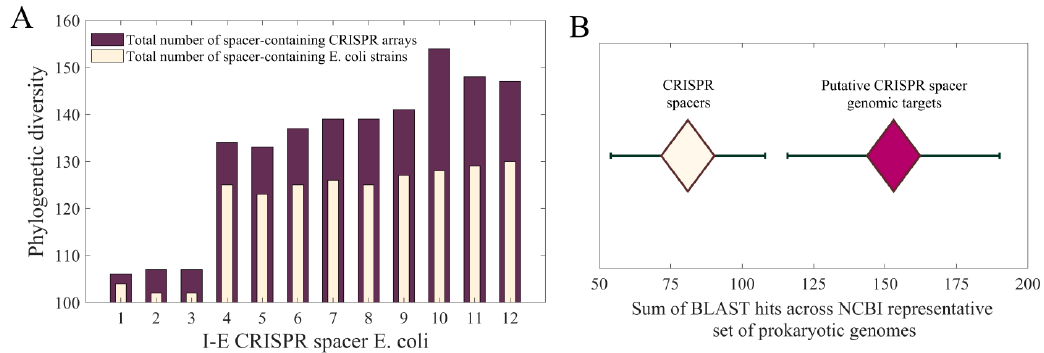
Figure 3. ( A ) Phylogenetic distribution of I-E E. coli CRISPR spacers throughout the domain of bacteria vs. E. coli species; ( B ) Phylogenetic distribution of I-E E. coli CRISPR spacers and their putative genomic targets across the NCBI representative set of prokaryotic genomes. For CRISPR array, the sum of hits obtained for all 12 spacers (with three standard deviations) is shown (white diamond). For CRISPR spacer genomic targets (19 targets per spacer), the mean number of hits, summed over 12 spacers, with three standard deviations, is shown (purple diamond).